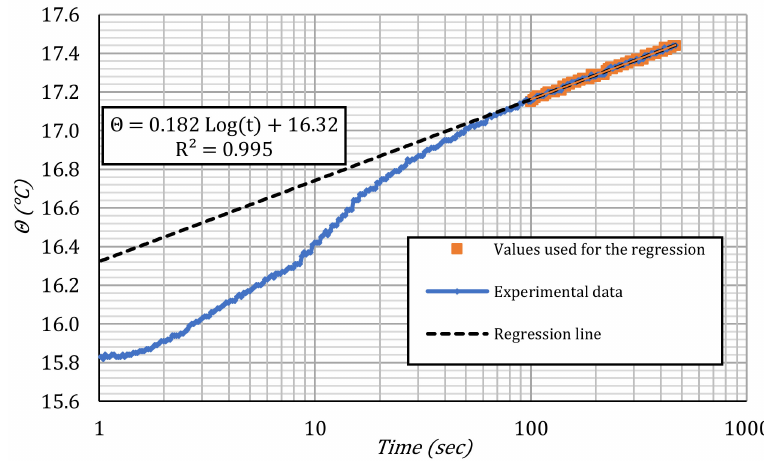
Figure 8. Example of data interpretation of a TRT performed through a thermal probe. The data refer to a linear power of q (cid:48) = 4.52 W / m, and a thermal conductivity of λ = q